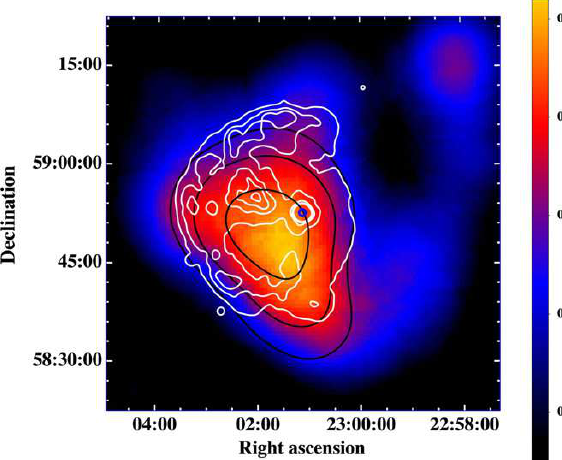
Figure 8: Smoothed Fermi-LAT count maps in the range 2 – 200 GeV (Castro et al., 2012). White con- tours show the X-ray emission (0.5 – 5.0 keV) from XMM-Newton